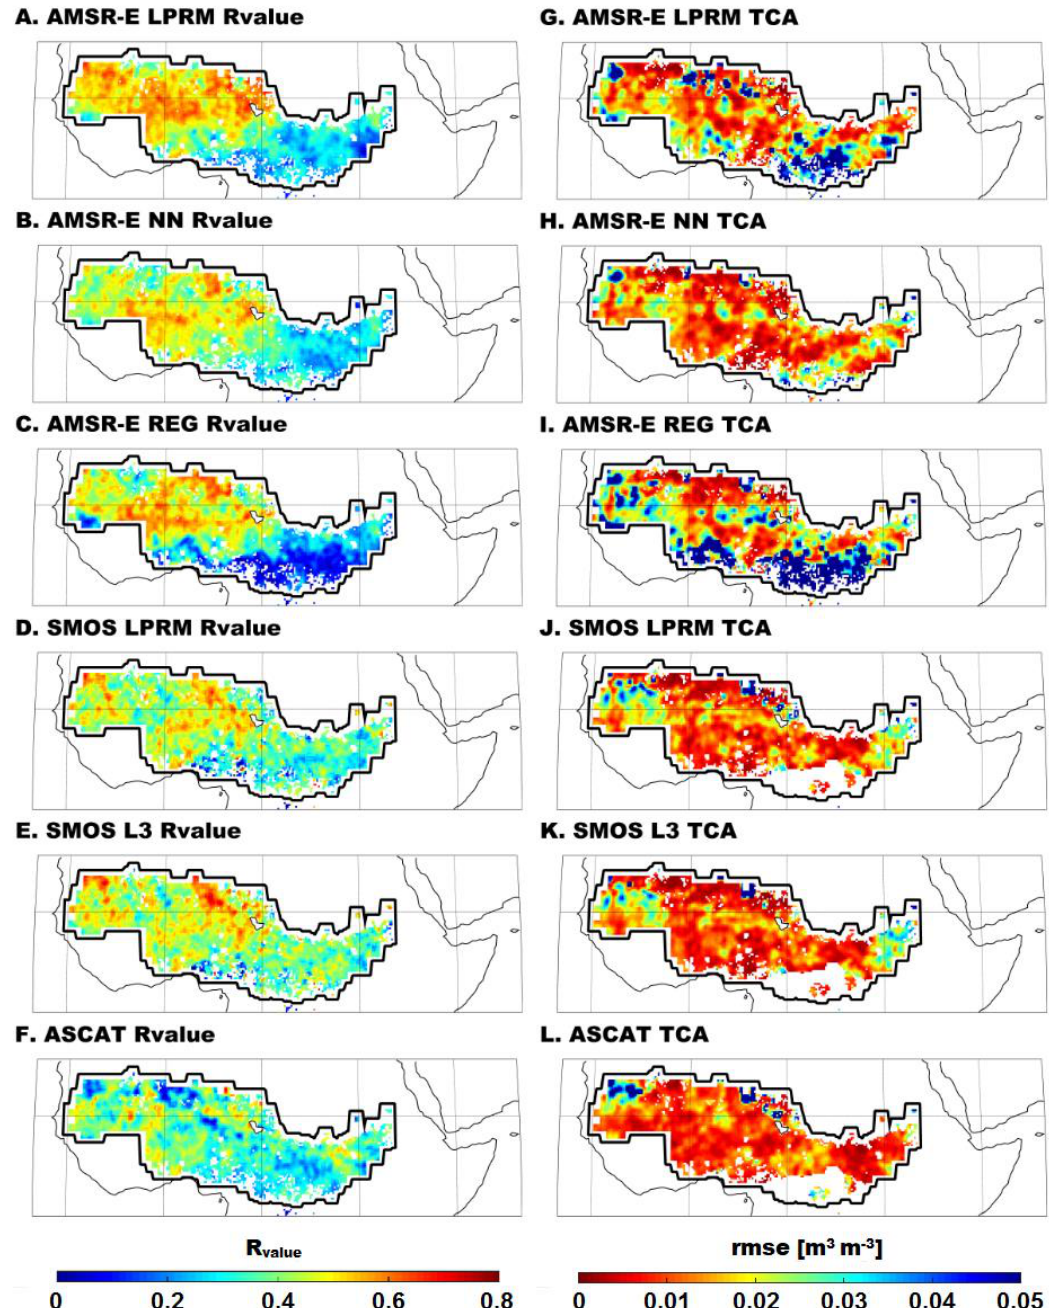
Figure 7. R value ( A – F ) and TCA ( G – L ) results over the Sahel.